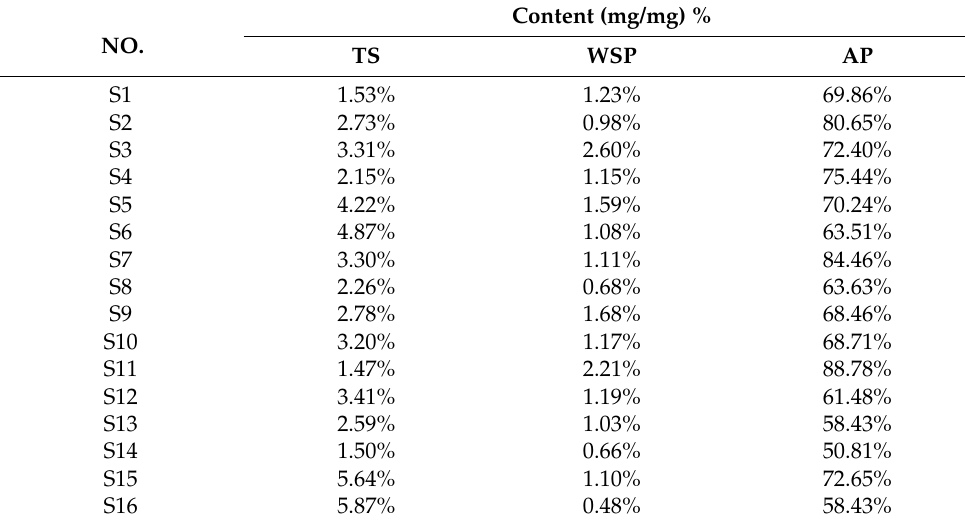
Table 1. Results of TS, WSP, and AP determination in